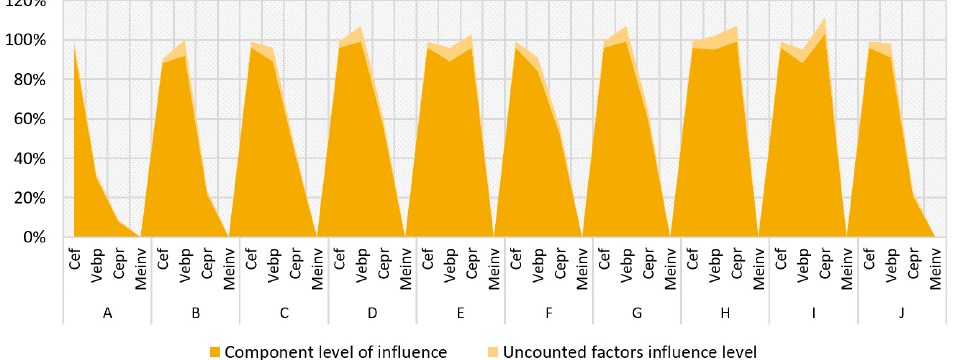
Figure 4. The level of influence of factors included (and not included) in the model on its performance in the companies under study. Source: generated by the authors.